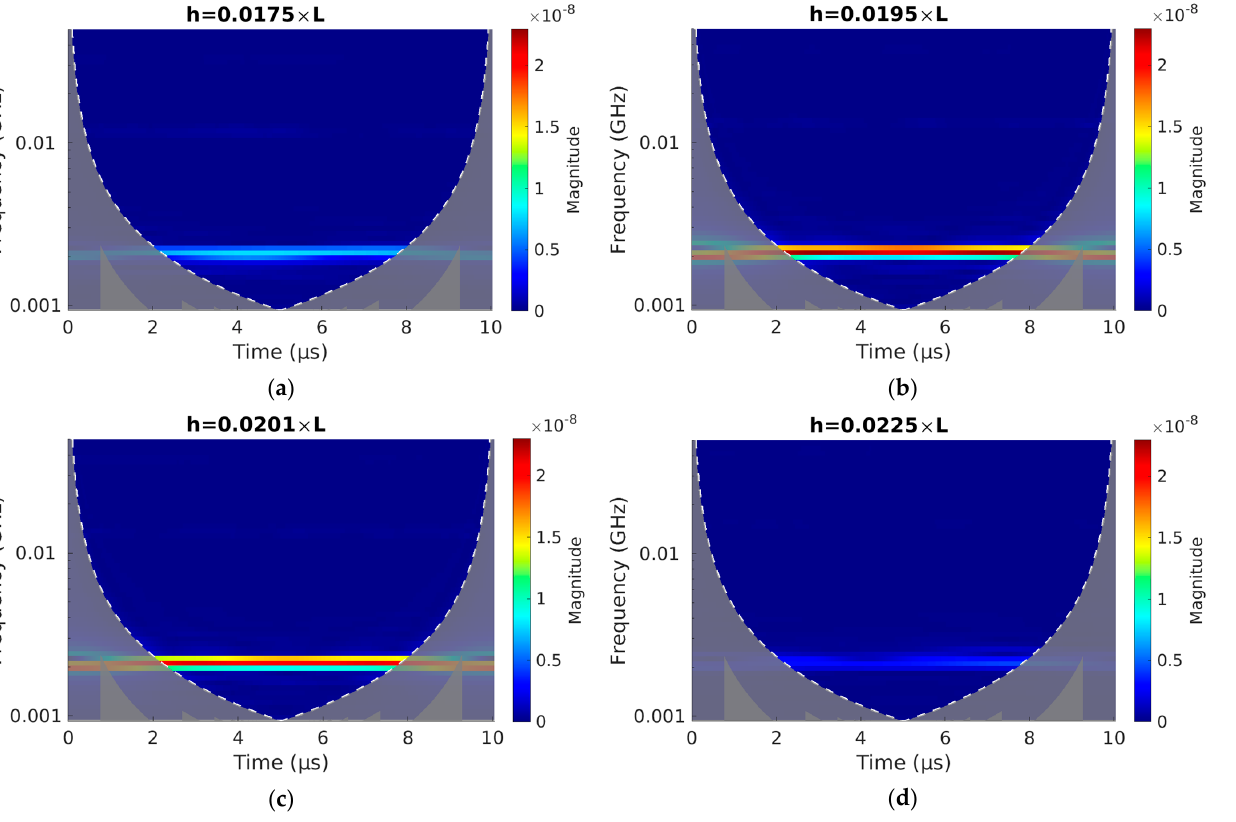
Figure 9. Continuous 1D wavelet transform with bump wavelet analysis of deflection of tip of beam for thickness of ( a ) 0.0175 L , ( b ) 0.0195 L , ( c ) 0.0201 L , and ( d ) 0.0225 L .